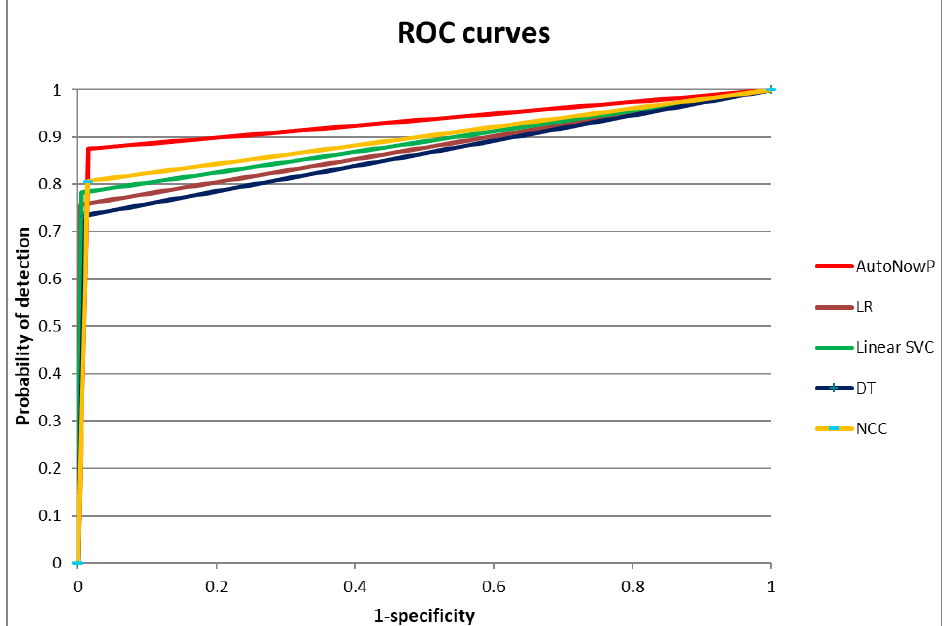
Figure 7. ROC curves for the classifiers from Table 4 on NMA data set.